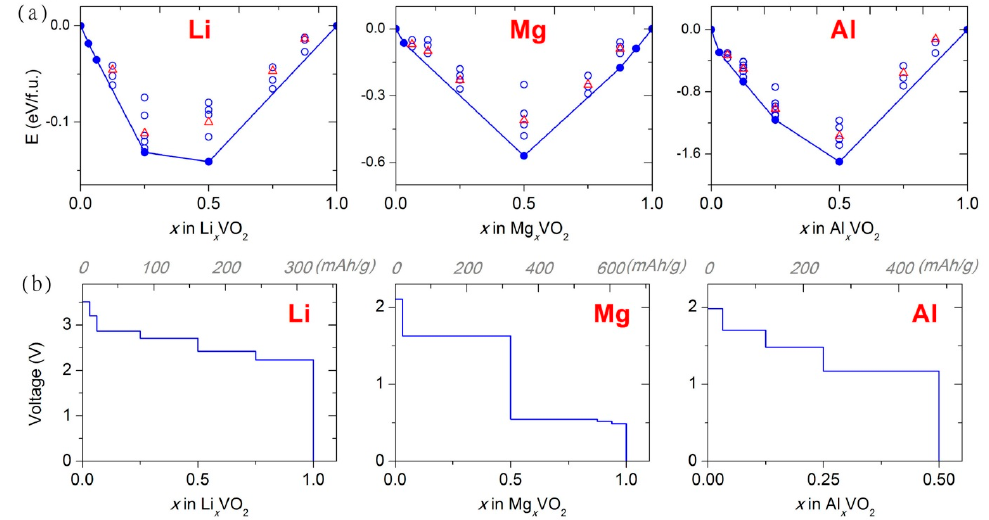
Figure 11. Multiple-atom Li, Mg and Al insertion in VO 2 : ( a ) calculated convex hull; and ( b ) calculated voltage-composition profile. Reproduced from [34] by permission of the PCCP Owner Societies, © (2017) Royal Society of Chemistry.